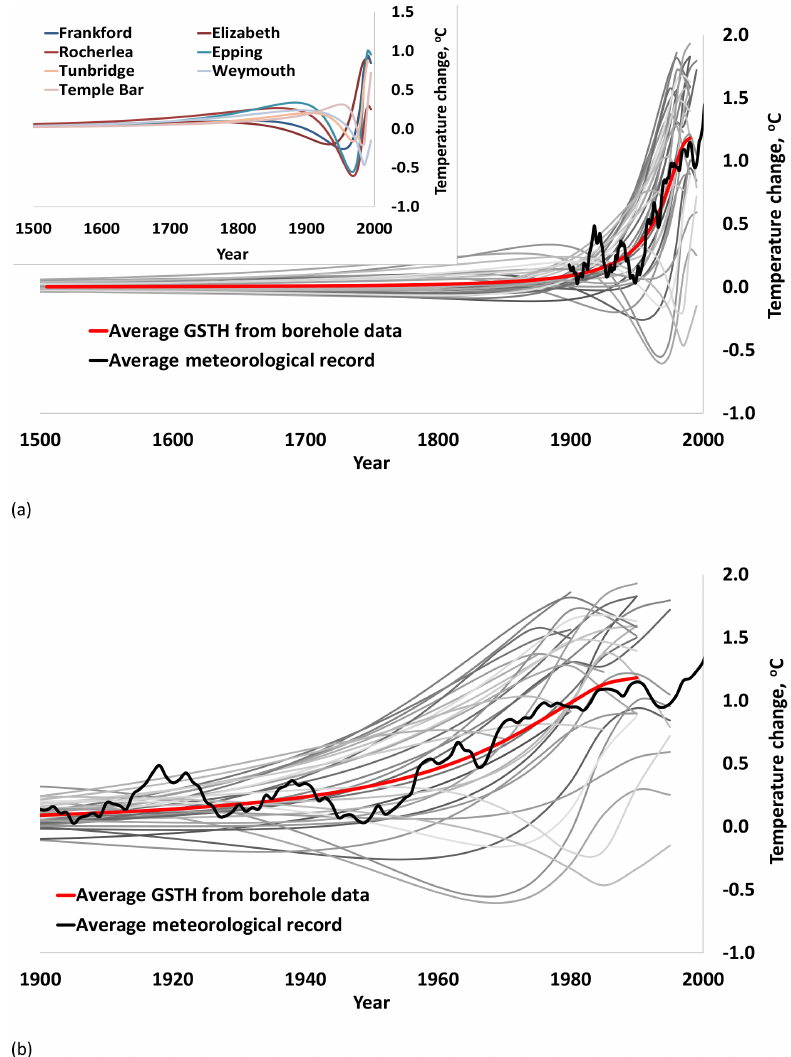
Figure 8. Reconstructed GSTH from the Tasmanian high-quality data set. The red line shows average reconstruction from 33 boreholes and temperature anomalies based on the long-term average (1500 to 1700 AD). The black line represents average temperatures from meteoro- logical data compiled from the surrounding five (Low Head no. 091293, Launceston no. 091311, Hobart no. 094029, Cape Bruny Island no. 094010, and Eddystone Point no. 092045) meteorological stations. Temperature change in the meteorological record was calculated from the mean of 1961 to 1990. Inset in panel (a) : reconstruction from seven boreholes shows early to mid-20th-century cooling before rapid warming at the end of the 20th century. Individual and average borehole reconstructions with an average meteorological record are only shown for the 20th century for visibility (b)